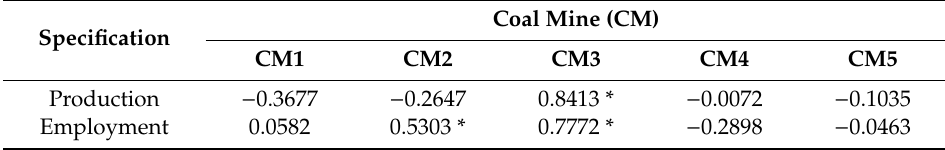
Table 4. Pearson linear coe ffi cients ( r xy ) between total costs and production volume and employment.